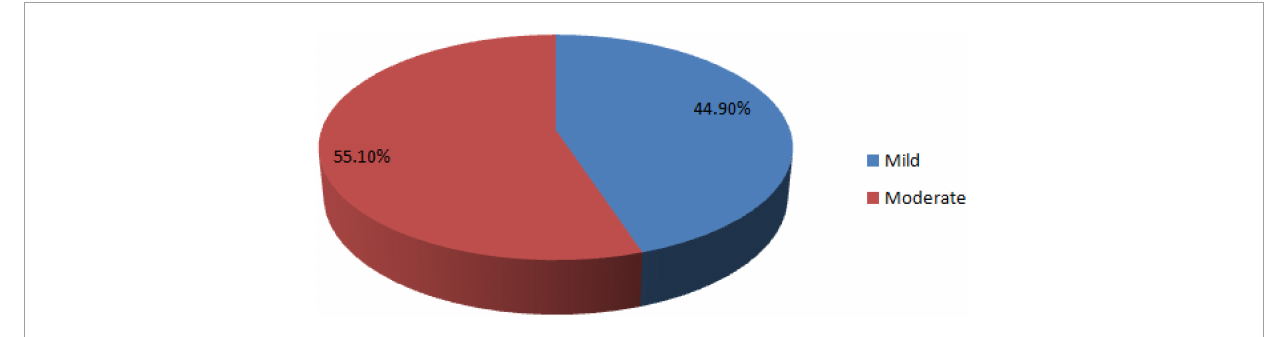
FIGURE1 Severity of preoperative anemia in women undergoing cesarean section at University of Gondar comprehensive specialized hospital, 2022.